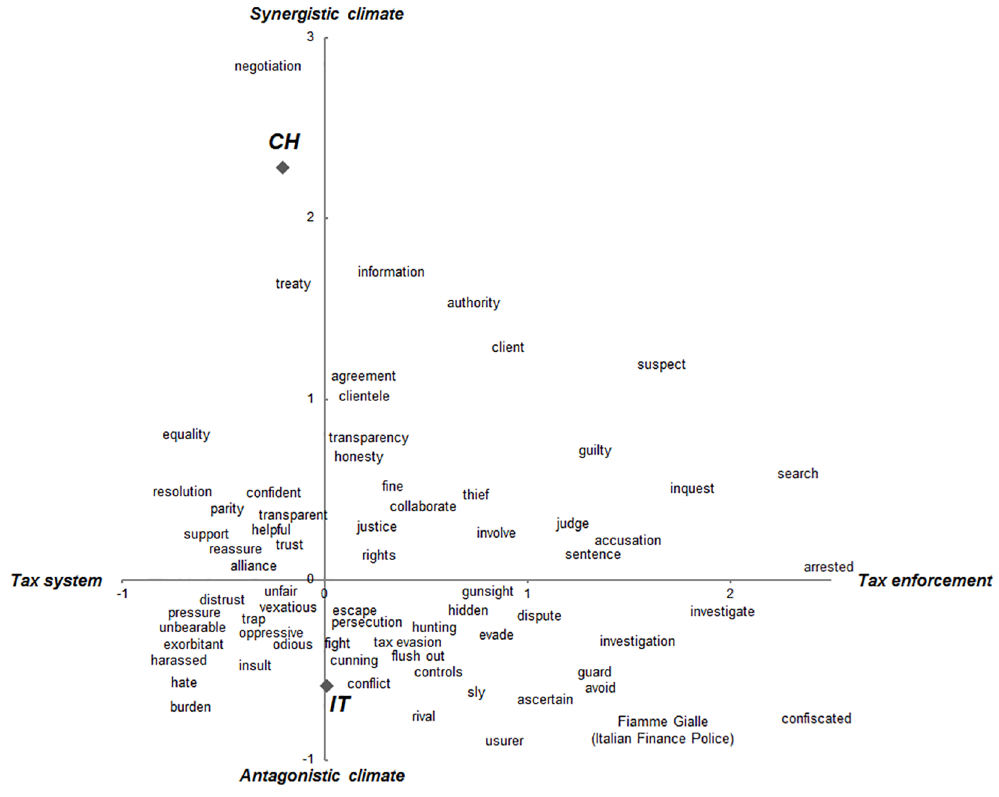
Figure 1. Two-dimensional solution of correspondence analysis (keywords × elementary